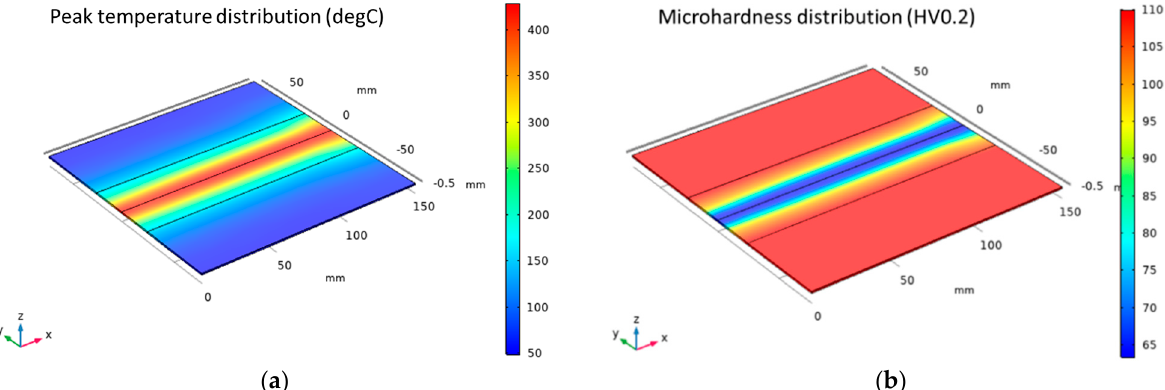
Figure 30. ( a ) Blank peak temperature distribution for the laser treatment carried out at the peak temperature of 420 °C and treatment speed of 5 mm/s; ( b ) Hardness distribution in the blank in T4 state for the laser treatment carried out at the peak temperature of 420 °C and treatment speed of 5 mm/s.